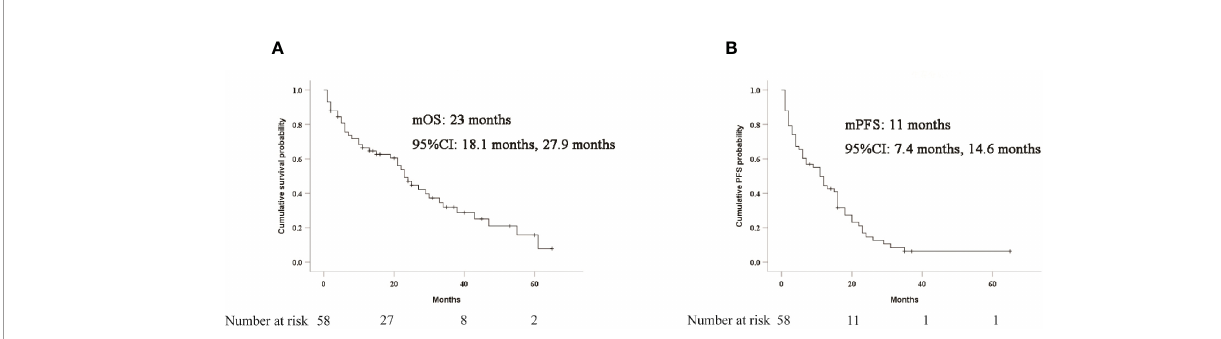
FIGURE 2 | Kaplan-Meier curves of survival outcomes after TACE treatment in all patients.